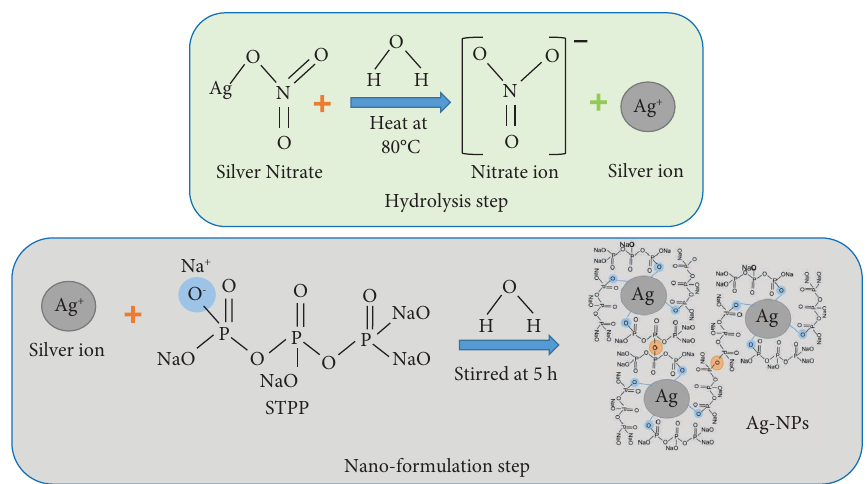
Figure 1: Schematic illustration of the Ag-NPs synthesis